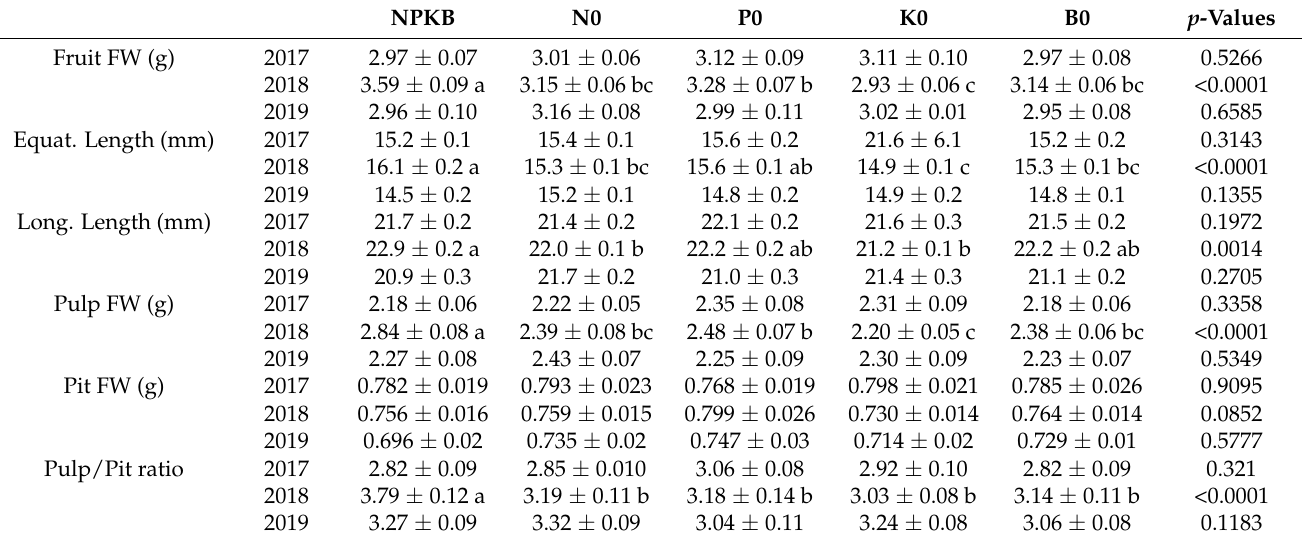
Table 2. Fruit, pulp and pit fresh weight (FW), equatorial length, longitudinal length and pulp/pit ratio (FW) from olive trees supplied with NPKB (control) and without N (N0), P (P0), K (K0) and B (B0) in the harvests of 2017, 2018 and 2019. NPKB N0 P0 K0 B0 p -Values